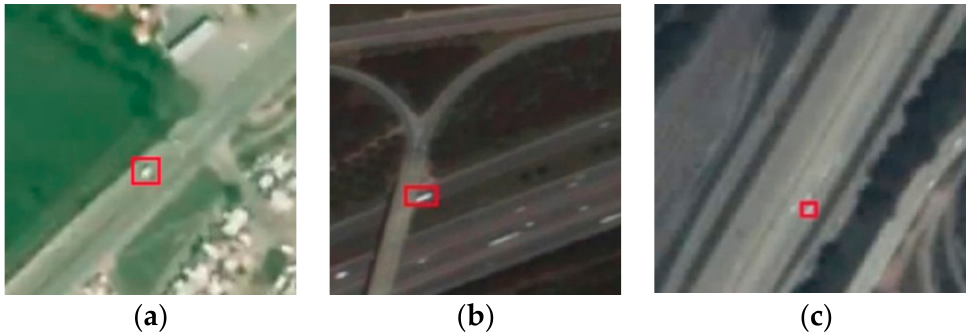
Figure 1. Satellite videos. ( a ) small object size is about 10 × 12 pixels. ( b ) the moving object is occluded. ( c ) the object is similar to its background.